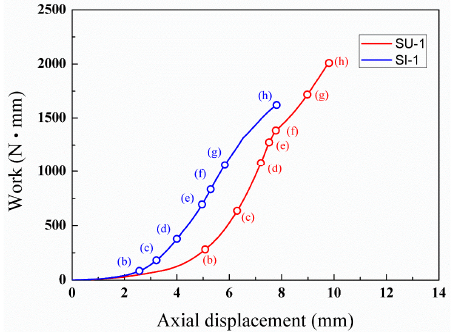
Figure 11. Changes in work during loading.